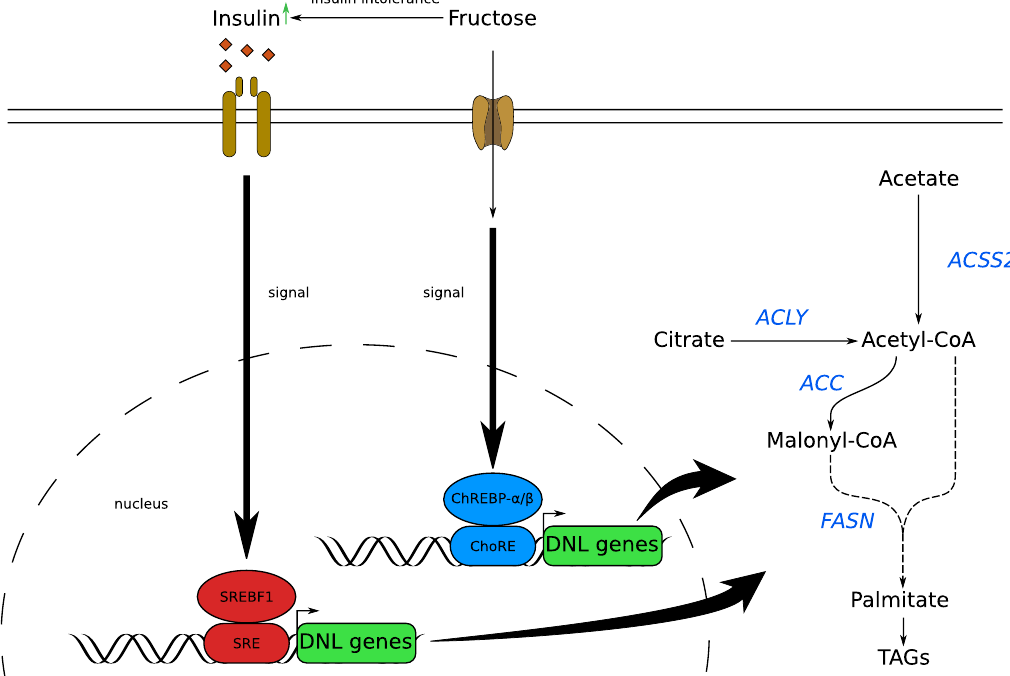
Figure 4. Fructose signaling effects on DNL gene expression. Fructose intake activates ChREBP, which binds to ChRE, a promotor of lipogenic emzymes. Furthermore, fructose is also involved in SREBF-mediated DNL gene expression. SREBF is activated by insulin signaling, binds to SRE, promoting gene expression of lipogenic enzmyes. Increased fructose consumption results in insulin resistance, which in turn increases insulin secretion in a compensatory manner. Therefore, fructose consumption affects DNL gene expression by ChREBP and SREBF signaling. ACC: